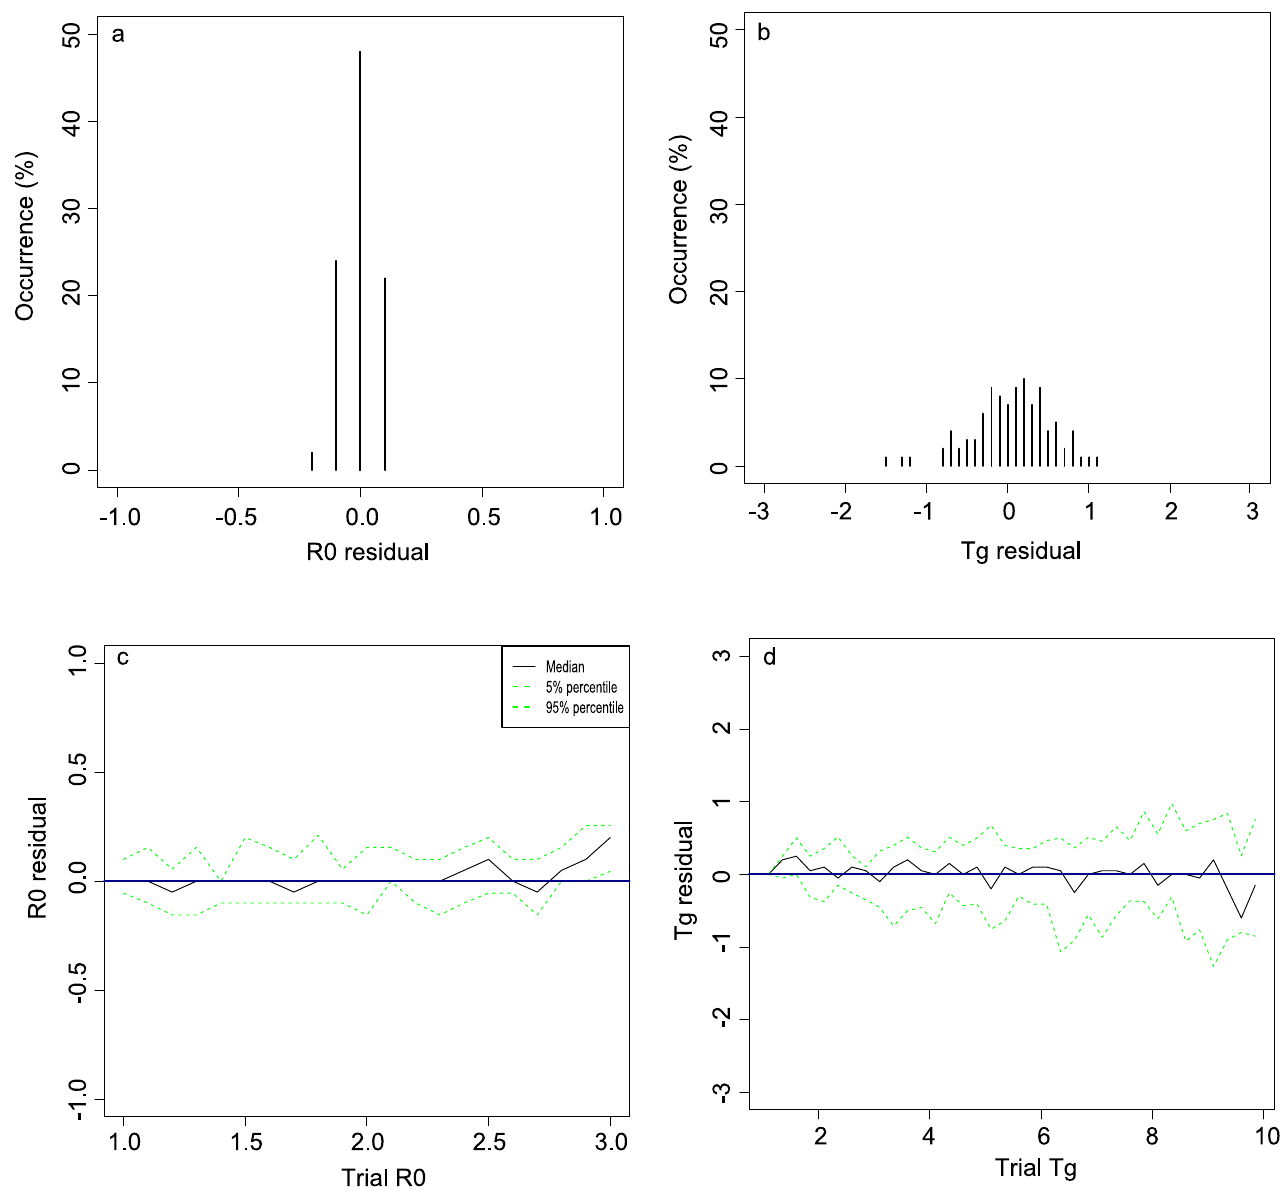
Fig 4. Extended assessment of univariate inference for Scenario 1. Sensitivity analysis using univariate estimations at single time point and assumed poission-distributed serial interval. a and b show the distribution of the marginals for estimation of R 0 and T g of 50 realisations respectively. All estimates were made at day 50. c shows the mean and confidence intervals for the marginals for estimates for R 0 across a wide range of known values for T g . Similarly, d shows the mean and confidence intervals for T g across a wide range of value for R 0 . Scenario 1 is as per Fig 1A with R 0 = 1.8, T g = 2.5, and k =